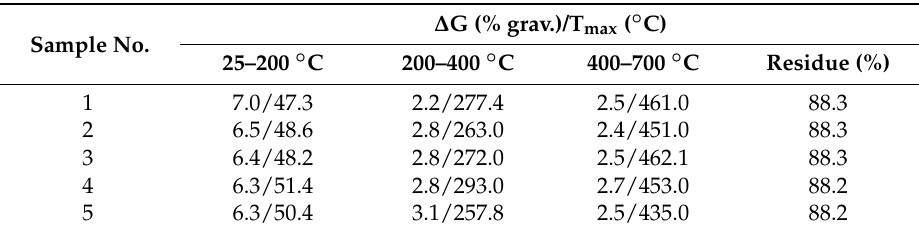
Figure 3. Environmental scanning electron microscopy (ESEM) images of dried pristine SiO 2 NPs